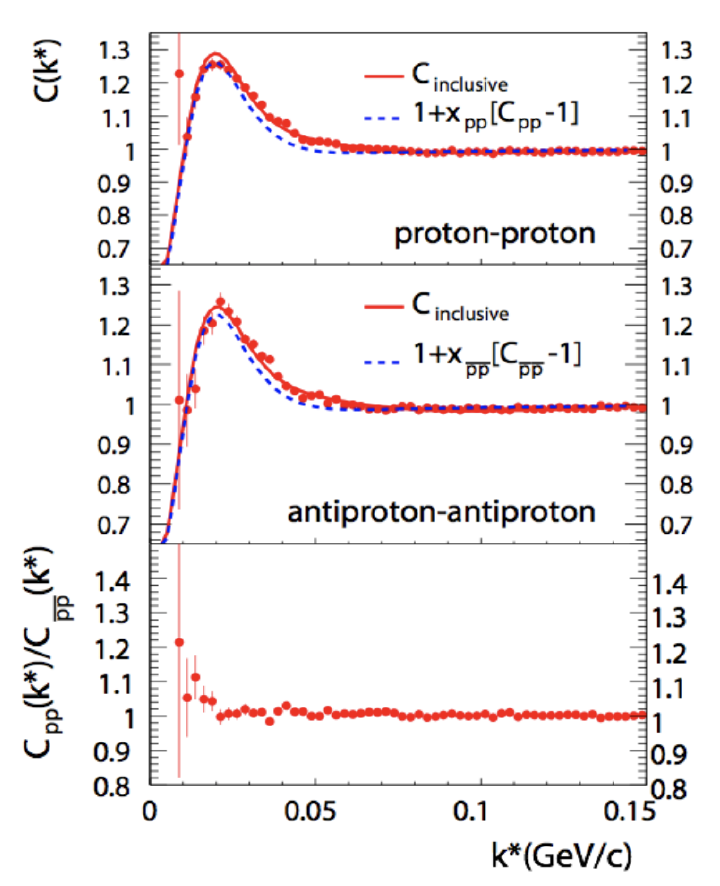
Figure 1. Proton-proton (top), antiproton-antiproton (middle) correlation functions and their ratio (bot- √ s NN = 200 GeV. tom) for Au + Au collisions at